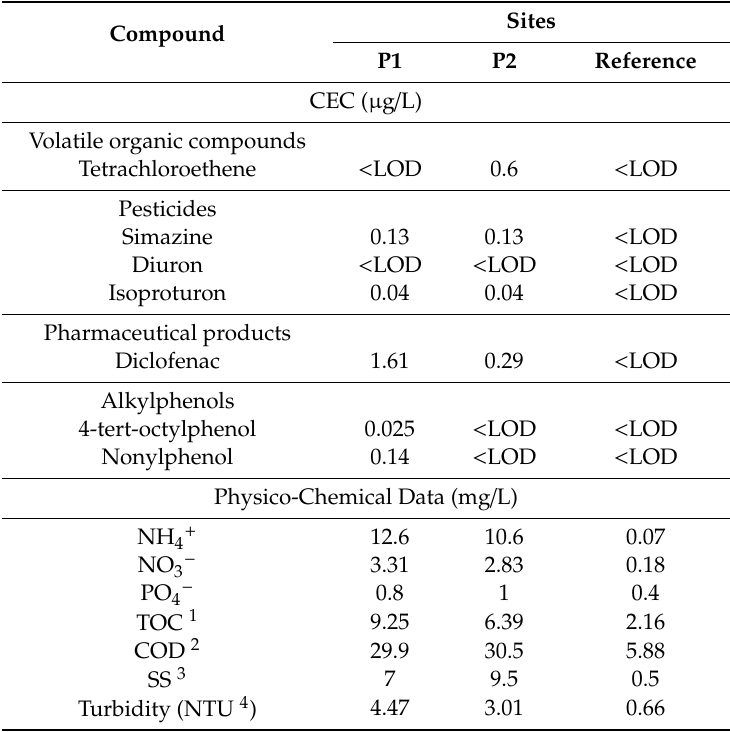
Table 1. Occurrence of contaminants of emerging concern (CEC) and physico-chemical data from river water samples collected within the wetland system (P1 and P2) and the reference non-impacted site located outside the system (Reference) in May 2017, when fish were sampled. Compound